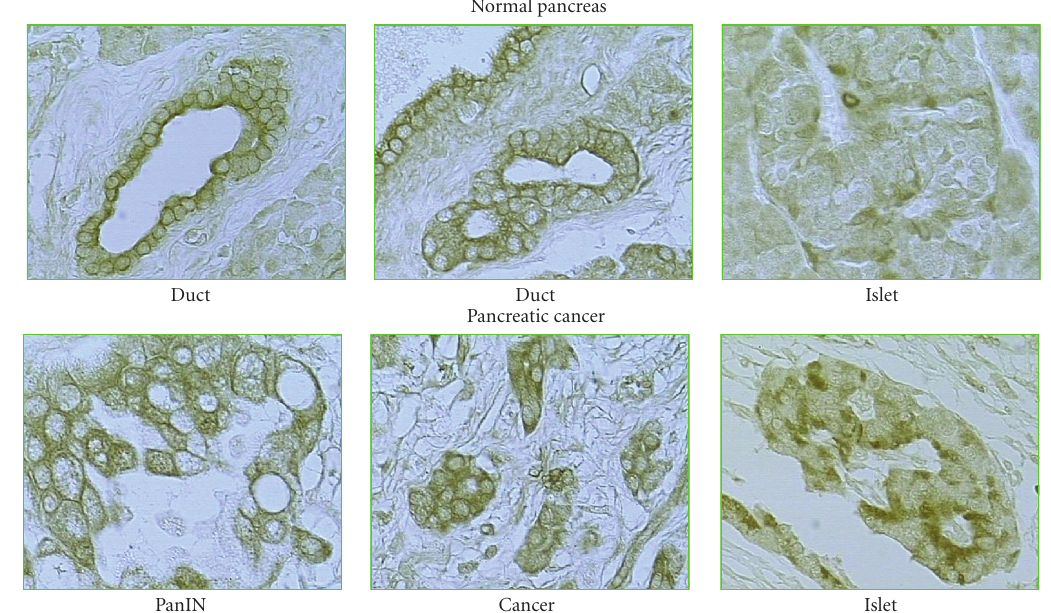
Figure 1: Immunocytochemistry of PPAR γ receptor in normal human pancreas and in a PanIN lesion and a pancreatic cancer. The PPAR γ receptor antibody shows a similar intensity of nuclear staining in normal ducts and in pancreatic cancer cells as well as cells in the PanIN lesion. In contrast, no staining is seen in normal islets, but nuclear staining is seen in islets from tissue adjacent to a cancer. These pictures are representative of eight samples of each tissue type. Staining was similar using antibodies from two di ff erent commercial